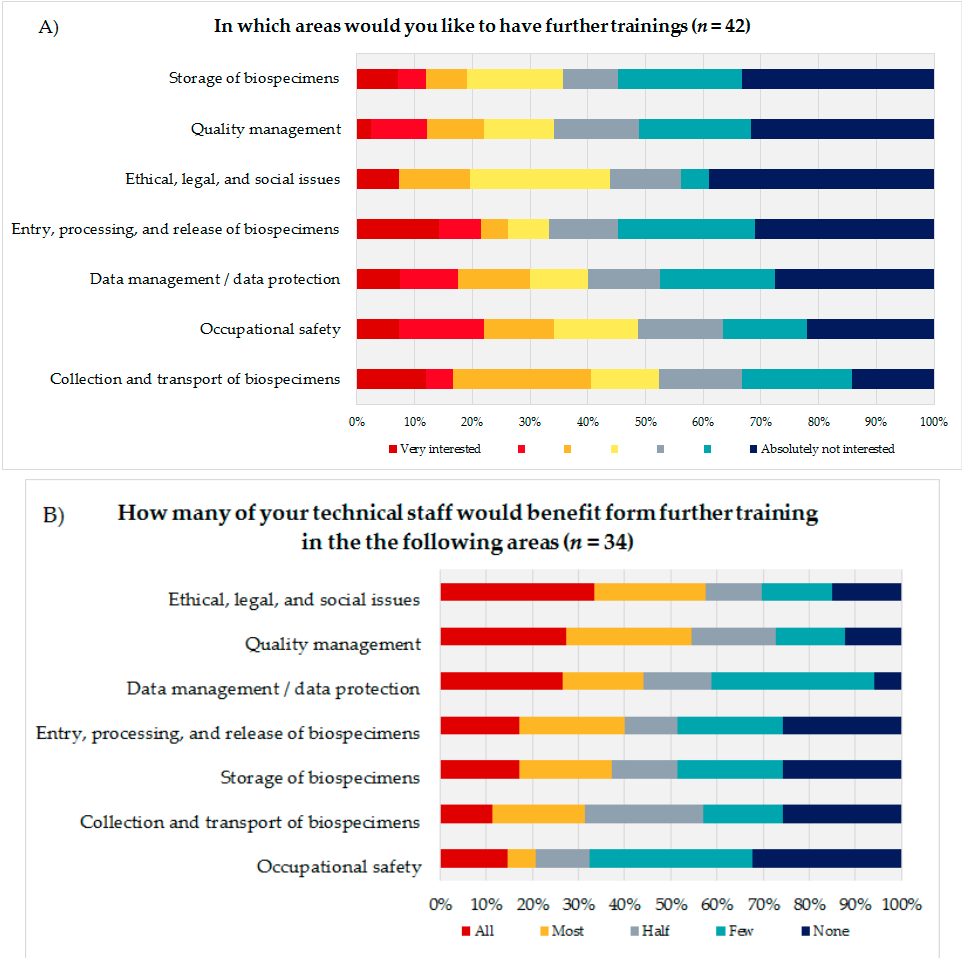
Figure 3. ( A ) Evaluation of seven presented biobank topics by the technical personnel. ( B ) Estimation of the coworkers of the technical personnel on how many of their technicians would need advanced training in the presented biobank topics.